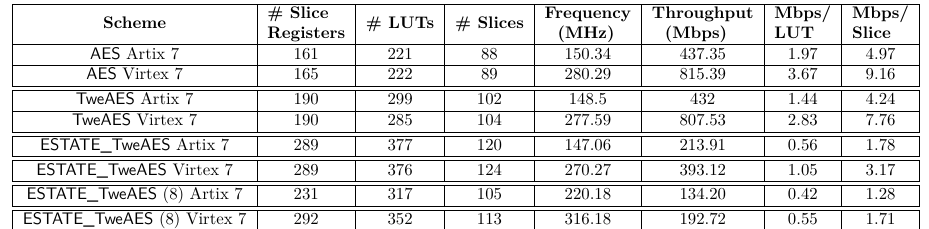
Table 8: Very Small Implementations of ESTATE _ TweAES in FPGA Results Scheme